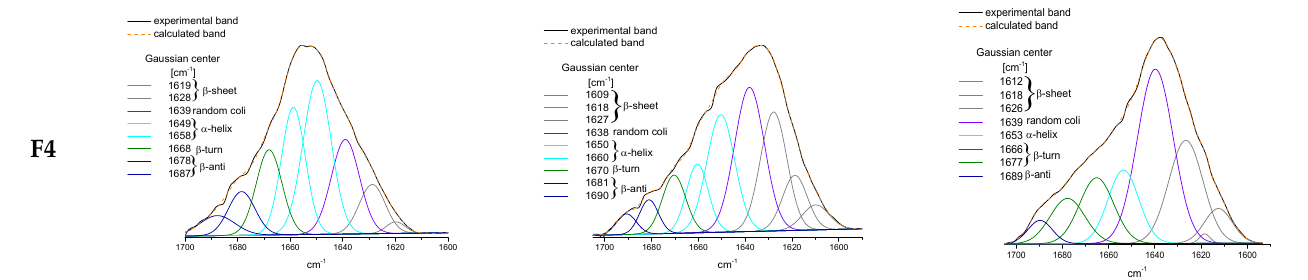
Figure 6. The deconvolution of amide I band of blood serum proteins BSA, AAG, and GG and complexes with compounds F1–F4, obtained by ATR-IR spectra.